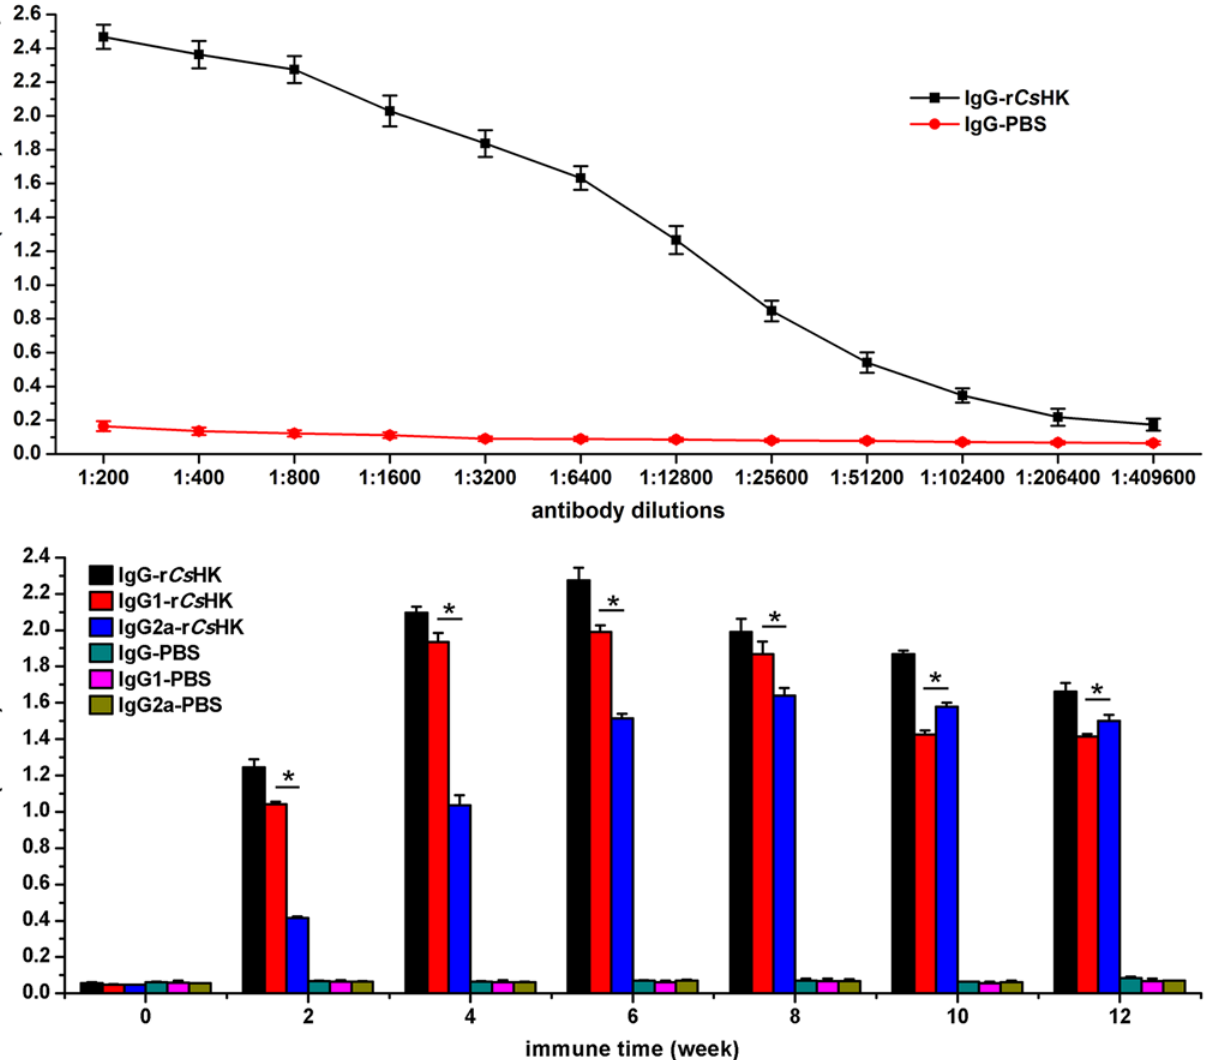
Fig 5. ELISA of antibody titers and isotype of IgG induced by r Cs HK. (A) Antibody titers of IgG induced by r Cs HK. (B) IgG isotype induced by r Cs HK. * p <